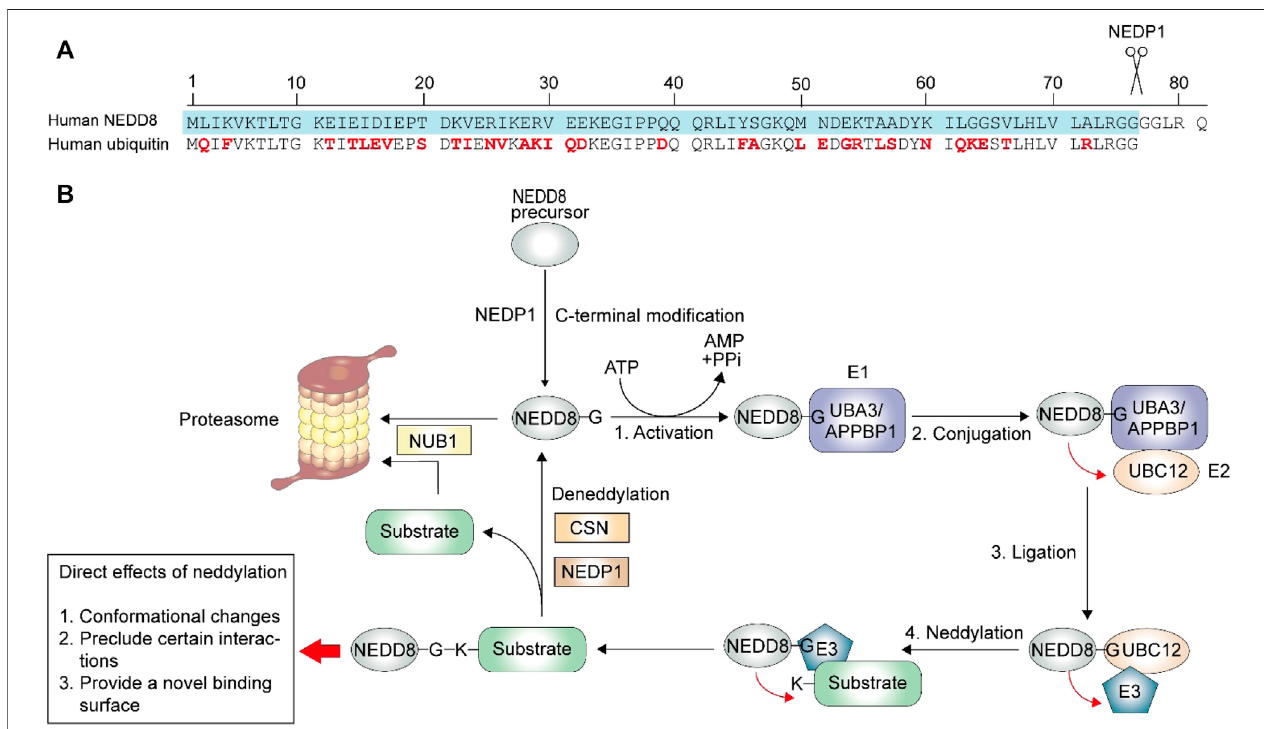
FIGURE 1 | Neddylation process. The neddylation process is similar to ubiquitination, with a three-step enzymatic reaction. (A) The maturation of the NEDD8 is a C-terminal hydrolytic activity by NEDP1. The ubiquitin contains 76 amino acids, and the different residues between matured NEDD8 (blue) and ubiquitin is highlighted in red. (B) After maturation, NEDD8 binds to the activating enzyme E1 in an ATP-dependent manner. NEDD8 is then accepted by conjugating enzyme E2. Finally, E2 transfers NEDD8 to ligase E3, which then links the glycine of NEDD8 and the lysine residues of its substrates via an isopeptide bond. The following deneddylation process deconjugates NEDD8 from the neddylated substrate. And after deconjugation, NUB1 (Negative regulator of ubiquitin like proteins 1) directs NEDD8 and substrate (like CRLs) to proteasome for degradation. The direct effects of neddylation on its substrates include three parts: conformational changes, preclude certain interactions and provide a novel binding